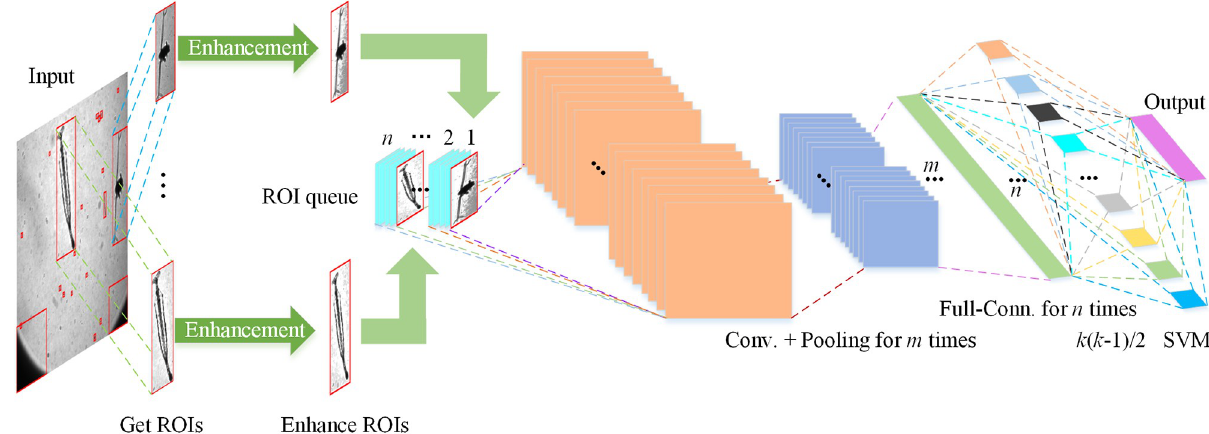
Fig 2. A flow chart illustrating the different steps and modules in the proposed automated plankton identification and enumeration procedure.